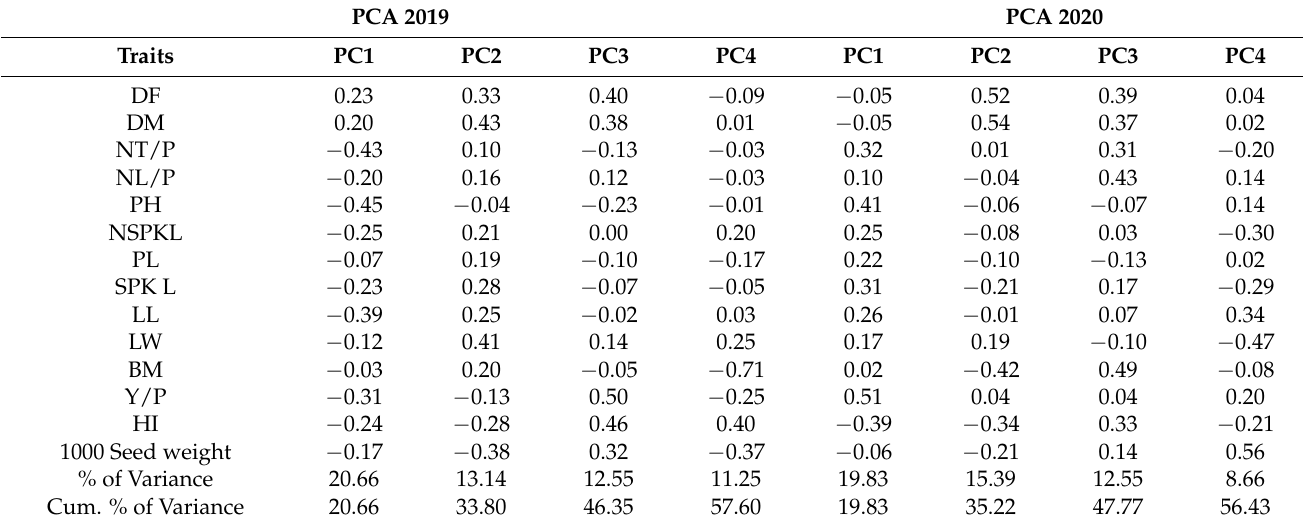
Table 3. Principal components analysis of the 14 agro-morphological traits of Oat (Avena sativa)